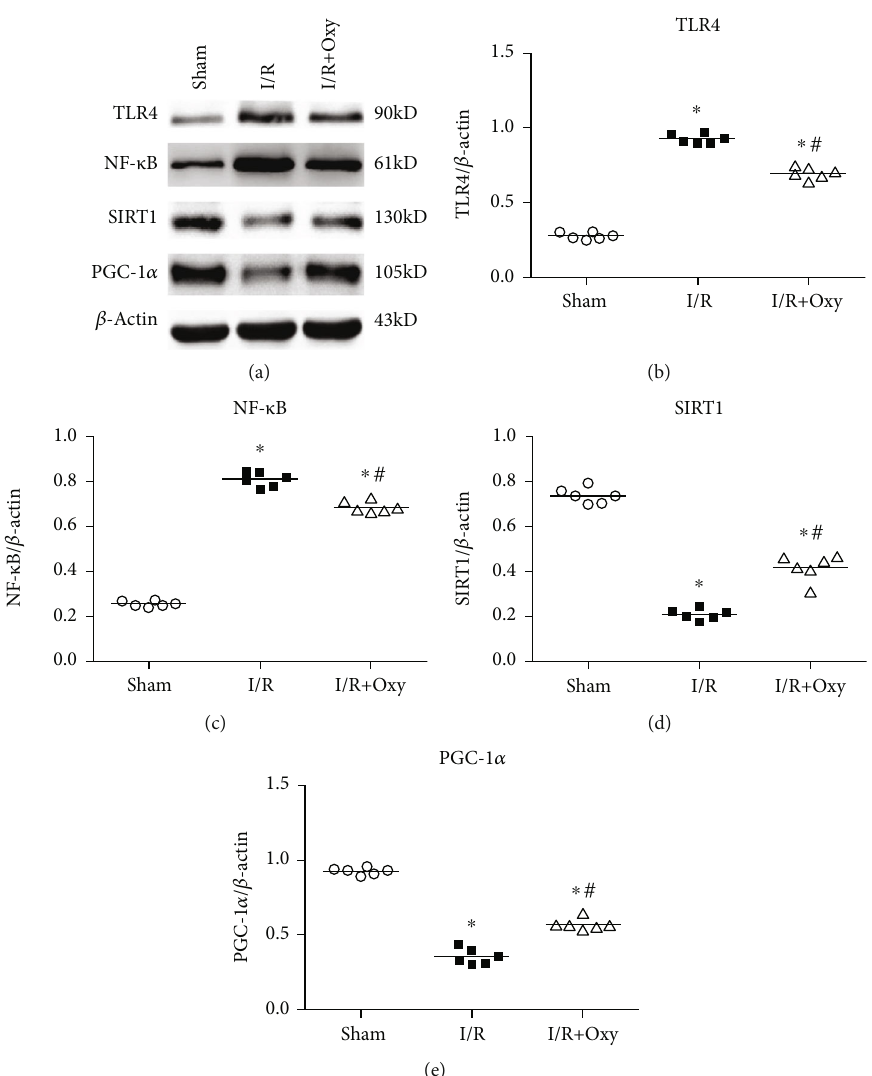
Figure 6: Oxy treatment decreased TLR4 and NF- κ B expression levels while increasing SIRT1 and PGC-1 α levels in tourniquet-induced I/R in gastrocnemius muscle tissues. (a) Representative band images for TLR4, NF- κ B, SIRT1, and PGC-1 α in the I/R and Oxy-treated I/R groups. (b – e) Summary data showing expression of TLR4 (b), NF- κ B (c), SIRT1 (d), and PGC-1 α (e). I/R: ischemia-reperfusion; Oxy: oxycodone. Data are expressed as the mean ± SE ( n = 6 in each group); ∗ P < 0 : 05 vs. sham; # P < 0 : 05 vs.